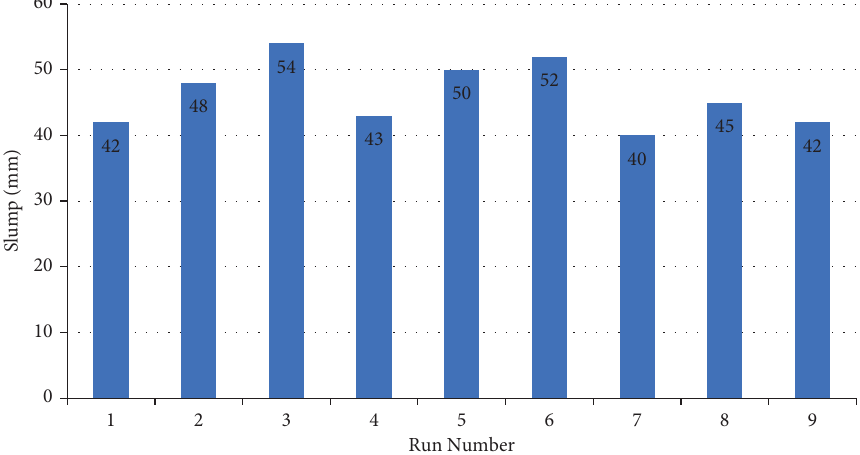
Figure 3: Slump properties of RHA and PETp-modifed concrete.